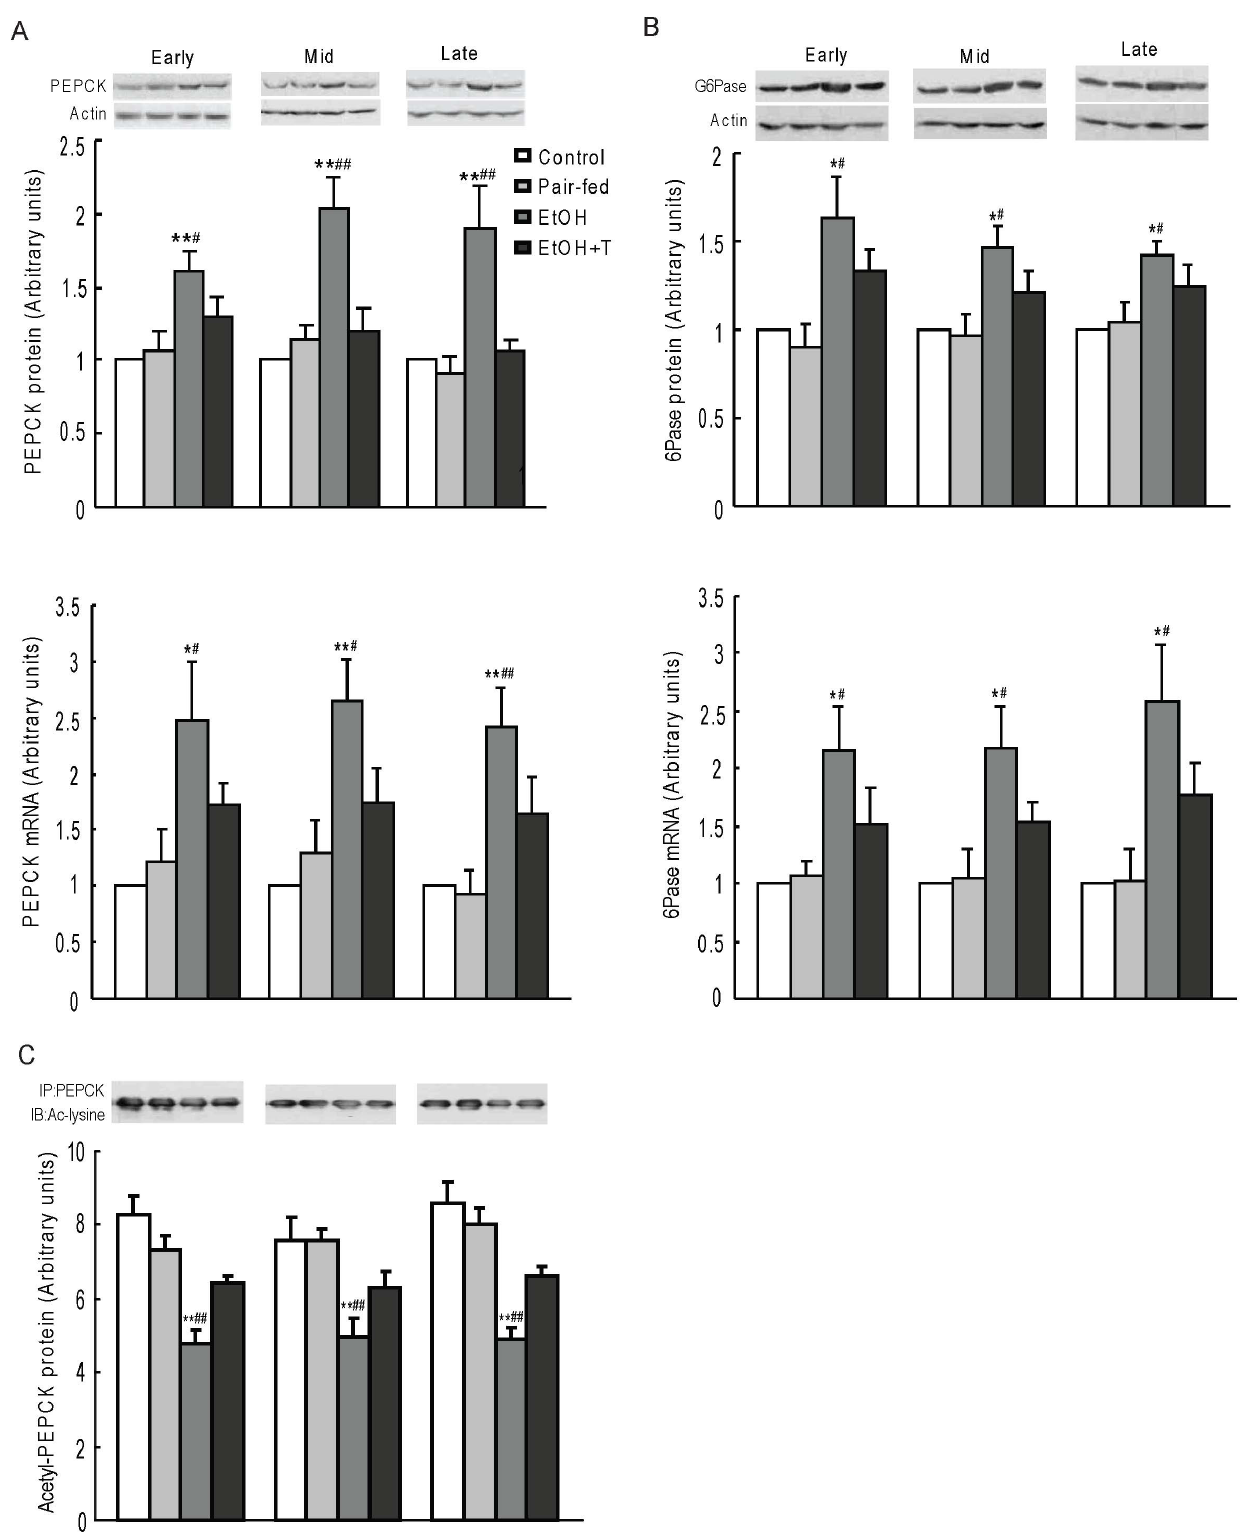
Figure 3. Hepatic nuclear PEPCK (A) and G6Pase (B) expression, and acetylated PEPCK (C) in 4 month-old male rat offspring exposed to ethanol (EtOH) or water only during early, mid, or late pregnancy. Control and pair-fed offspring were from dams with free access to chow and dams fed the amount of chow consumed by EtOH dams, respectively. A subgroup of EtOH rats was given TUDCA (T) 3 weeks before the experiments. Data shown as the mean 6 SE, n=6. *P , 0.05, **P , 0.01 EtOH vs. control; # P , 0.05, ## P , 0.01 EtOH vs. pair-fed.